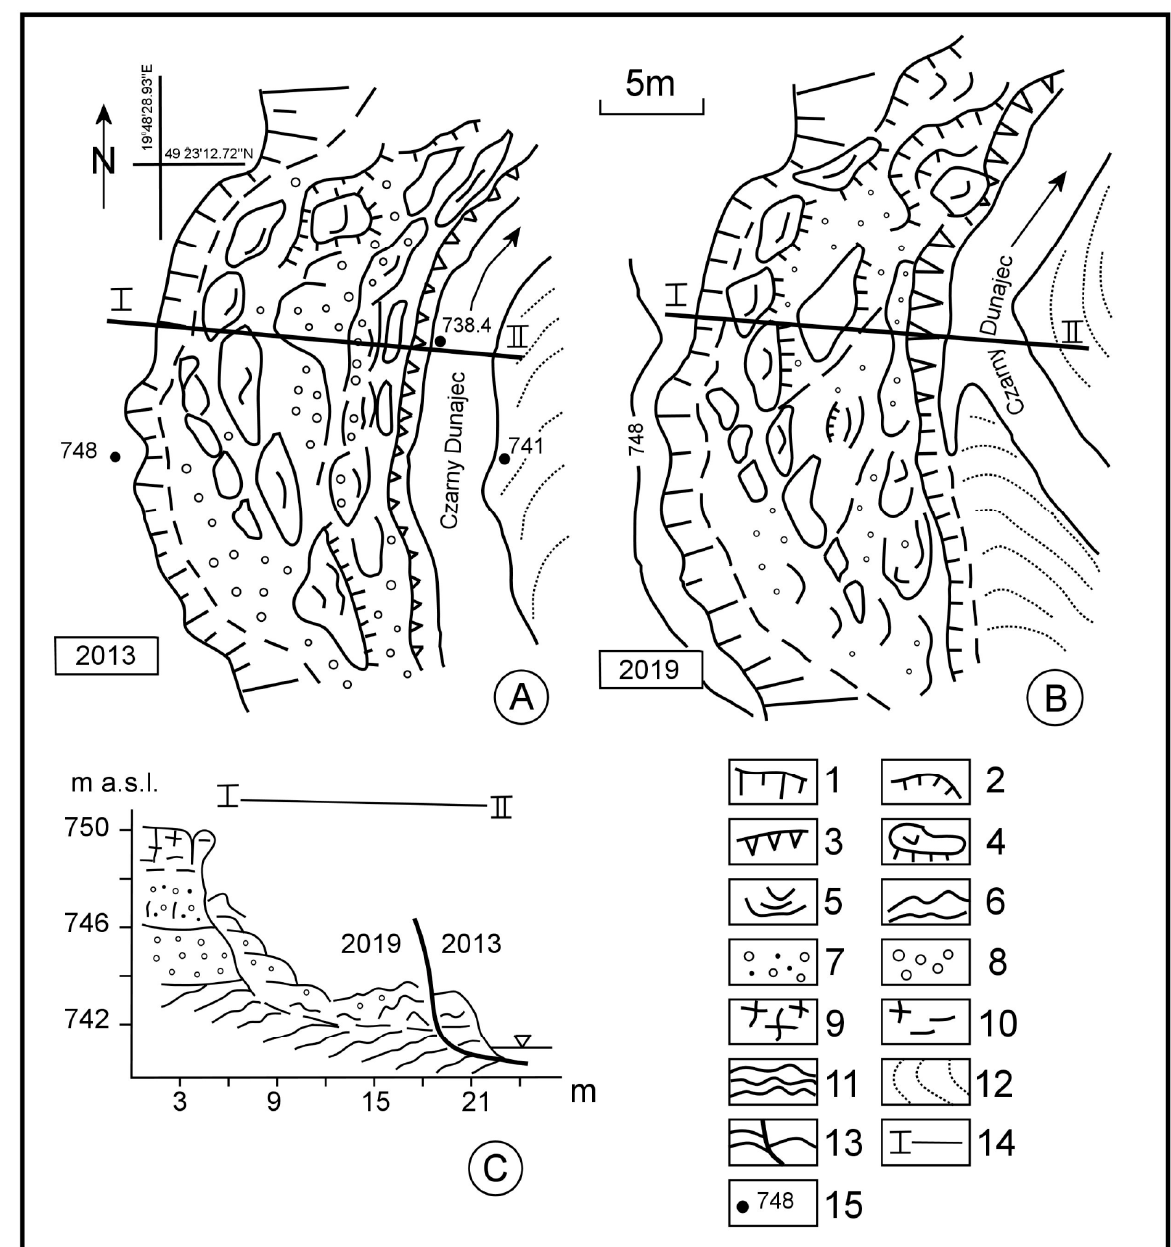
Figure 7. Transformation of the C-RCZ at site 1 in years 2013–2019; ( A )—2013 r.; ( B )—plan of the landslide and river channel in 2019 r.; ( C )—cross-section through the landslide and the C-RCZ; 1—main scarp of the landslide, 2—stable scarps on the landslide tongue, 3—last recorded position of the eroded front of the landslide tongue, 4—slices of colluvium; 5—ridges of gravel–clay colluvium, surface of fluvial erosion in the period 2013–2019, 14—cross-section line I-II, 15—m